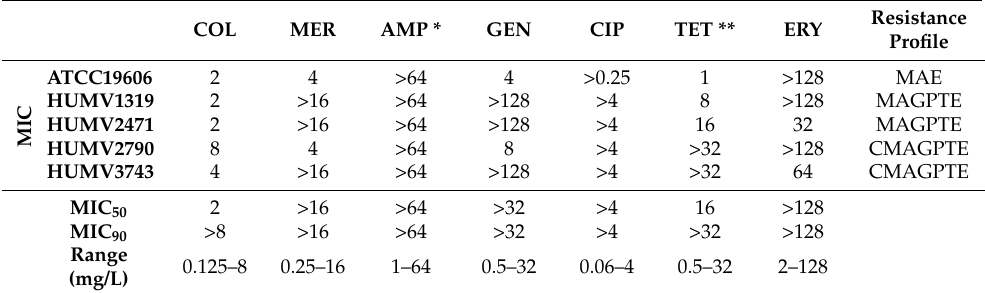
Table 2. Susceptibility of A. baumannii strains against seven antimicrobial agents. Isolates were classified as resistant according to EUCAST breakpoints [24]. For the resistance profile: COL (C) is colistin; MER (M) is meropenem; AMP (A) is ampicillin; GEN (G) is gentamicin; CIP (P) is ciprofloxacin; TET (T) is tetracycline; and ERY (E) is erythromycin. MIC is minimum inhibitory concentration; MIC 50 is MIC that inhibits 50% of the isolates; MIC 90 is MIC that inhibits 90% of the isolates. * No specific value for Acinetobacter , used general no species-specific breakpoints. ** CLSI breakpoints used [25].